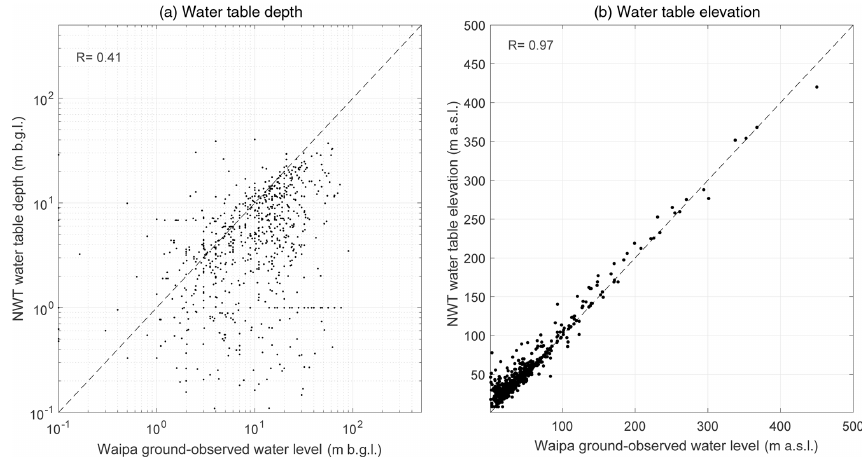
Figure 14. Correlation of NWT water table depth (100m lidar DEM, calibrated to ground observations) and water table elevation with ground observations in the Waipa River catchment. The dashed line is the 1 : 1